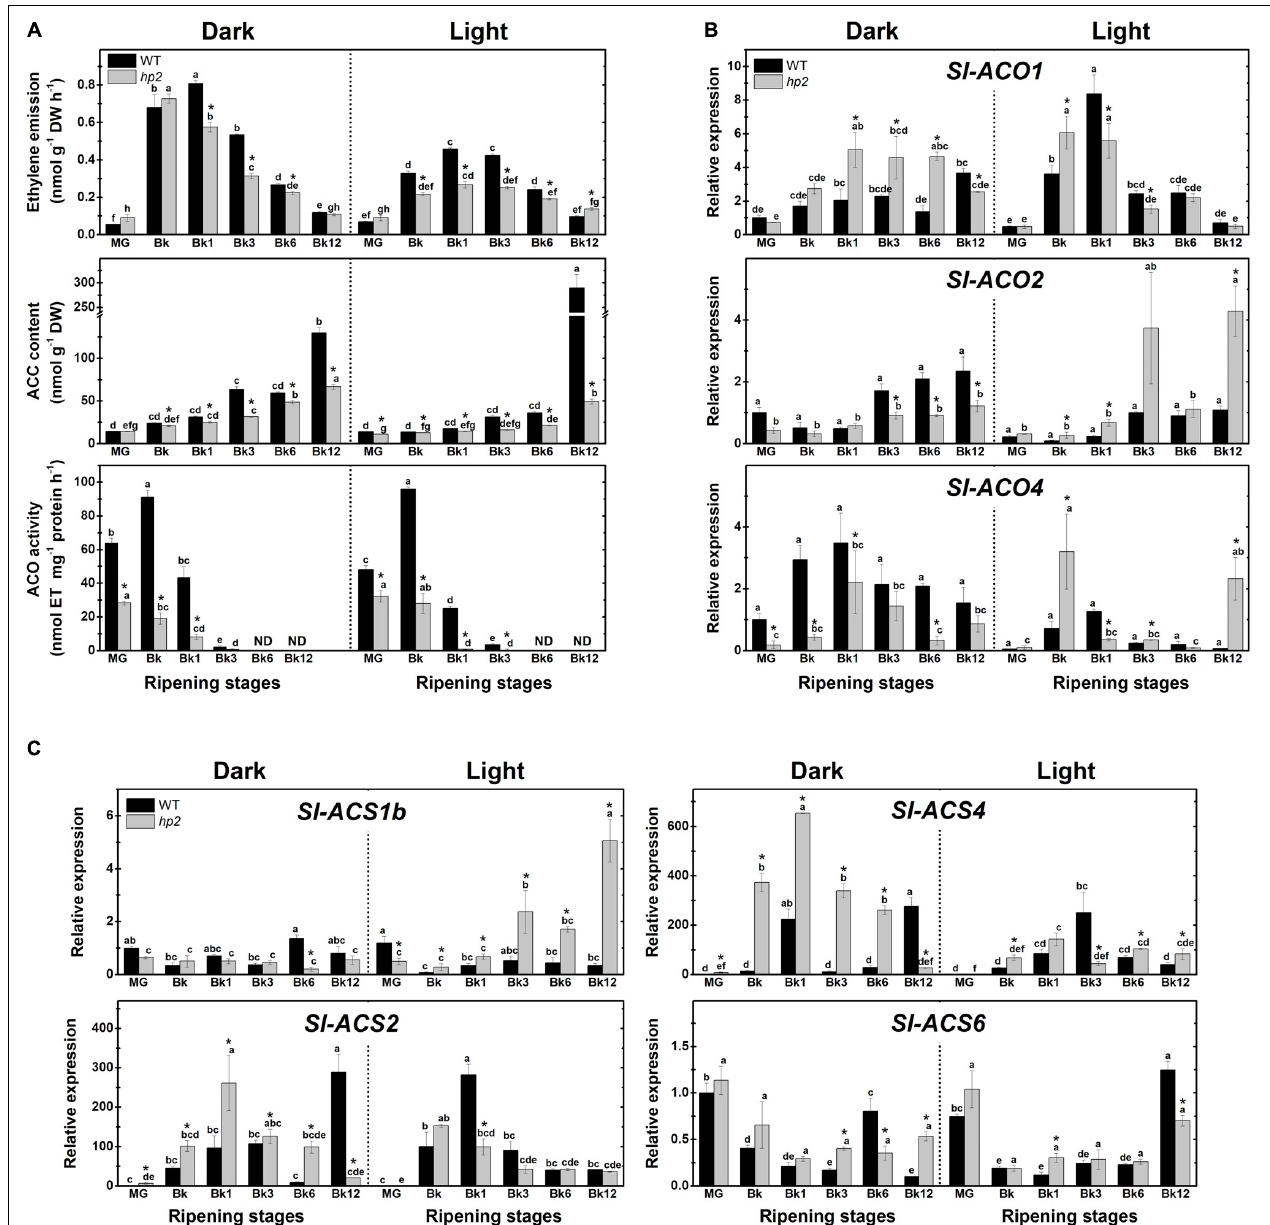
FIGURE 3 | Light-hypersensitivity represses ethylene metabolism in ripening tomato fruits. Treatment details as described in Figure 1 . (A) Ethylene emission, 1-aminocyclopropane-1-carboxylic acid (ACC) content, in vitro ACC oxidase (ACO) activity. (B) Relative mRNA levels of tomato genes encoding ACO. (C) Relative mRNA levels of tomato genes encoding ACC synthase (ACS). Mean relative expression was normalized against wild-type (WT) samples at mature green (MG) stage under dark conditions. Data are means ( ± SE) of at least three biological replicates. Different letters indicate statistically significant differences (Tukey’s test, p < 0.05) within each genotype. Asterisks indicate statistically significant differences (Student’s t -test, p < 0.05) between genotypes. hp2 , high pigment-2 ; Bk,